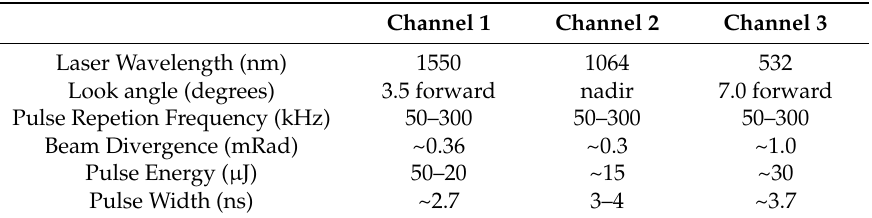
Table 1. Performance specifications of each of the Titan’s